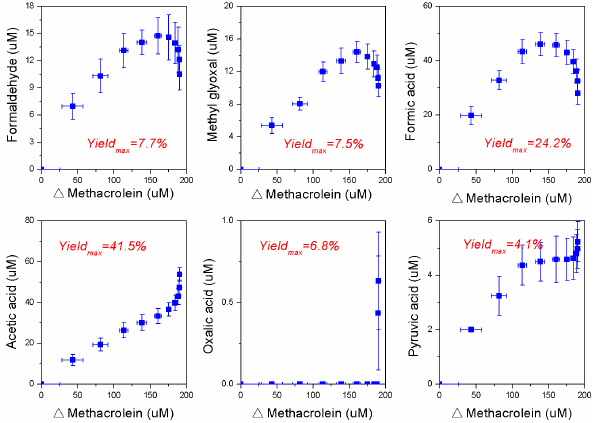
Fig. 6. Yields of low-molecular-weight products from the OH- oxidation of MACR.